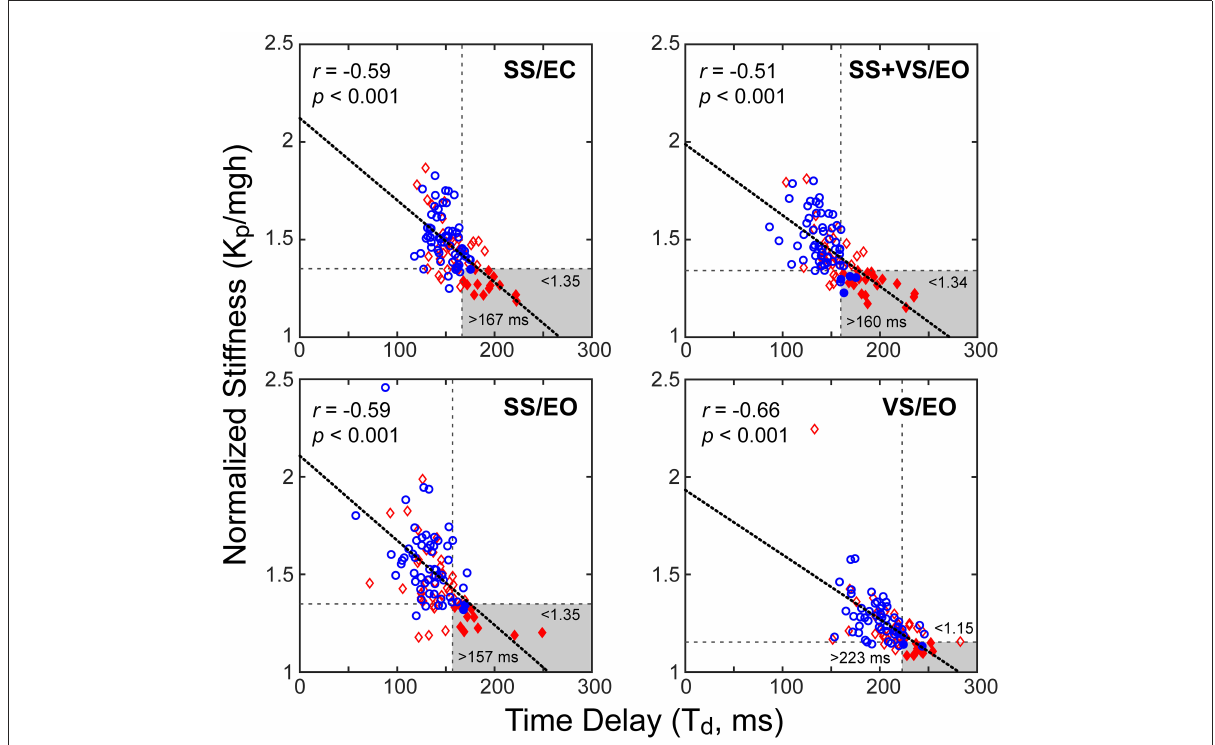
FIGURE7 Correlations between normalized stiffness (motor activation stiffness parameter, K p , divided by mgh (mass x gravity constant x height of body center-of-mass) and time delay, T d , for the four test conditions for combined data from control subjects (blue circles) and mTBI subjects (red diamonds). Longer time delays were associated with lower normalized stiffness values (thick dotted lines: linear regression fits). Horizontal and vertical dashed lines show 10 th percentile and 90 th percentile values based on control subject data for normalized stiffness and time delay parameters, respectively. Gray areas show long time delay – low stiffness regions based on control-subject percentile cutoffs with filled symbols indicating subjects whose parameters were within these